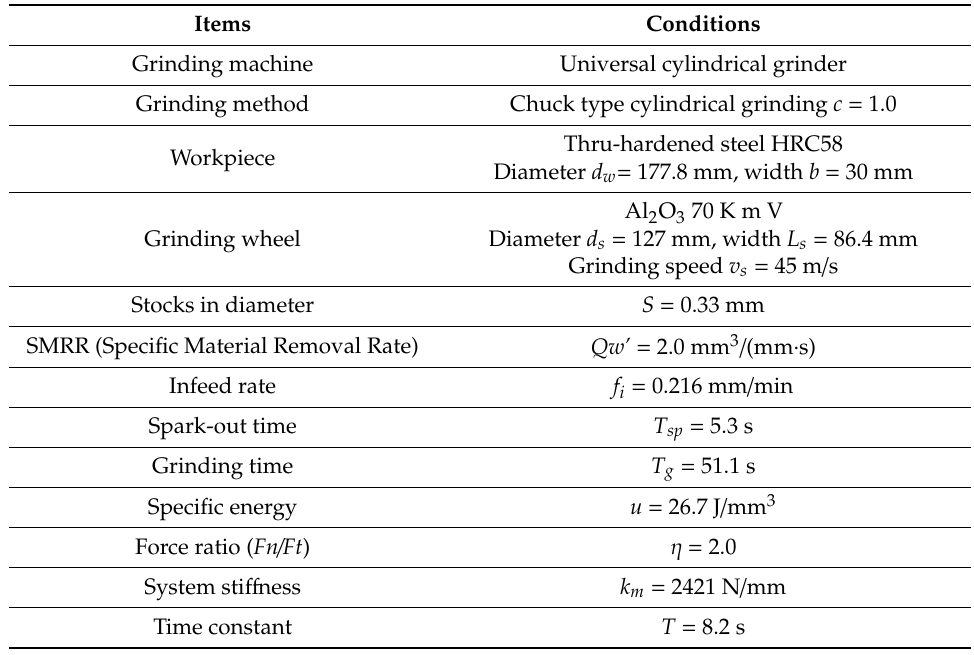
Table 1. Experimental setup in infeed cylindrical grinding.